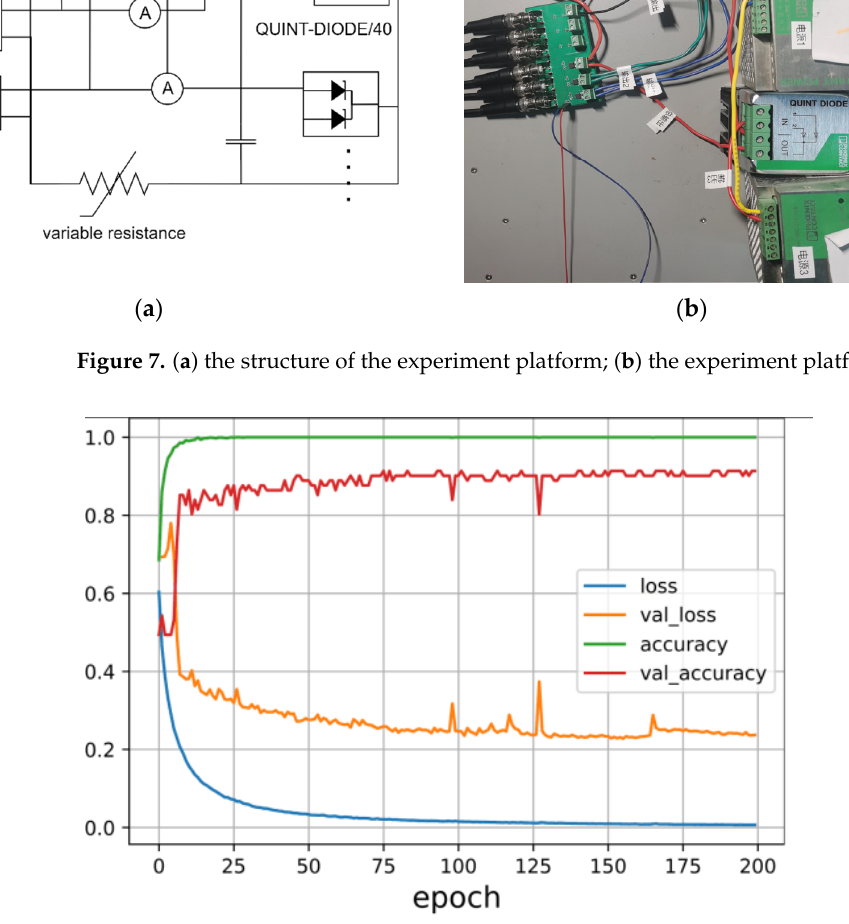
Figure 8. The training process.